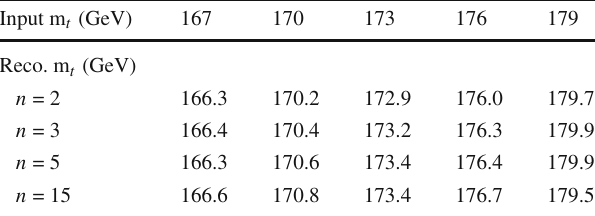
Fig. 5 Validation with different input values of the top-quark mass using the response distribution with m t = 173 GeV. The vertical axis indicates the reconstructed top-quark mass and the horizontal axis indi- cates the input mass. The dashed line indicates the ideal case where the input mass is the same as the reconstructed mass. The statistical uncertainty is shown together with the central value Table1 Inputandreconstructedmassesusingtheresponsedistribution with m t = 173 GeV. The statistical uncertainty for each mass value is